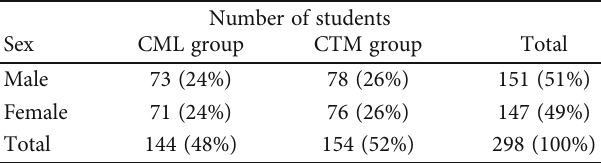
Table 1: Study sample